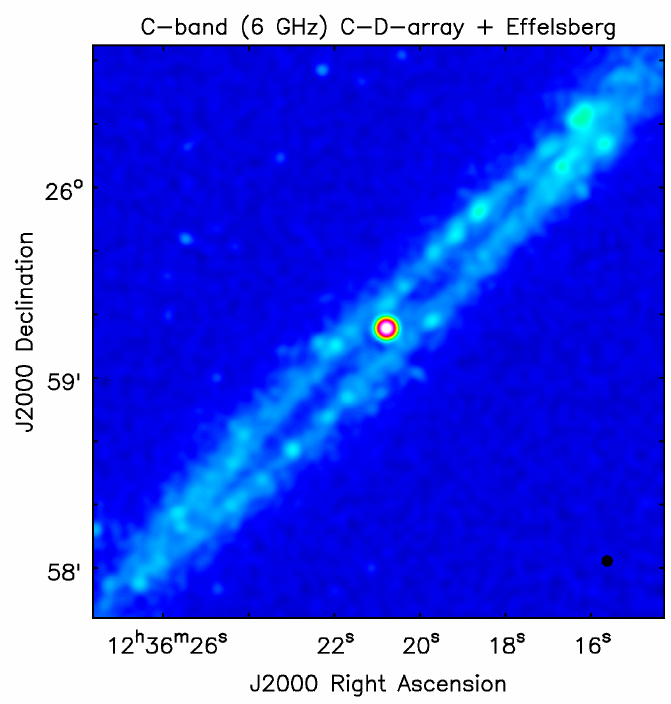
Figure 9. The galaxy, NGC 4565, in total intensity at C-band and resolution of 200 pc, zooming in on the large, thin, ring or inner spiral arms. From [31]. Notice the point-like core at the centre. The beam is shown as a small black dot at the lower right.